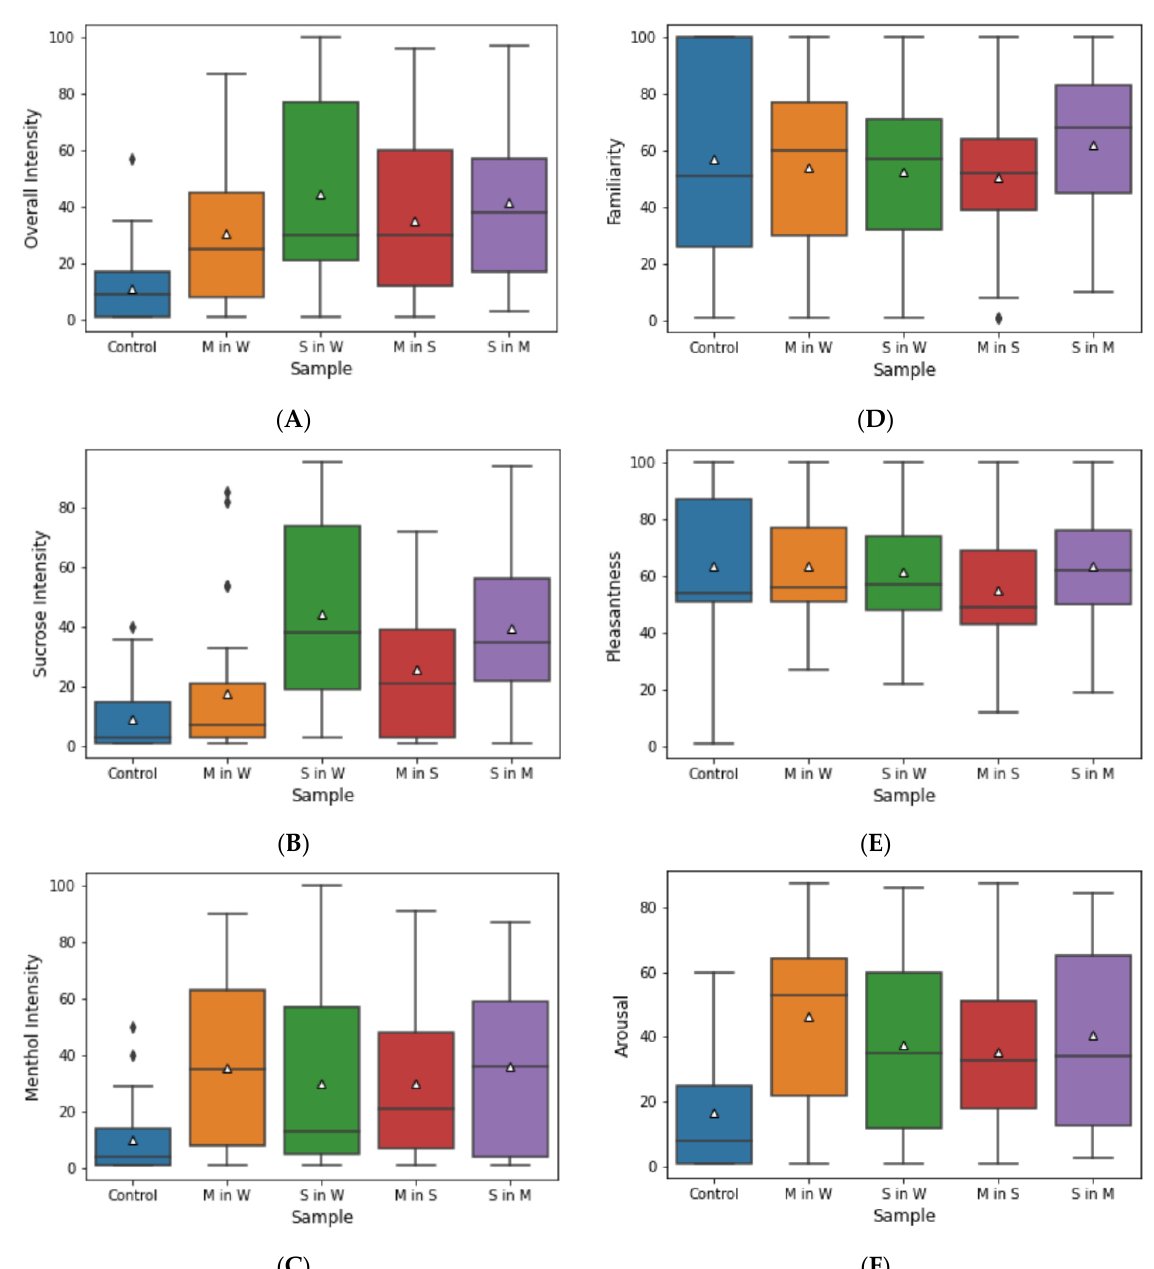
Figure 4. Conscious rating of water (control), menthol in water (M in W), sucrose in water (S in W), menthol in sucrose solution (M in S), and sucrose in menthol solution (S in M). Twenty-nine participants conducted the rating; intensity was rated on a scale from non- to strongly perceptible. All values were consciously rated by the individual tasters. △ symbolize the mean value, ◆ denote outlier values. Overall intensity of all samples ( A ). Intensity of sucrose perception ( B ). Intensity of Menthol perception ( C ). Familiarity of the samples was rated on a scale from not familiar to very familiar ( D ). Pleasantness of the samples, rated from very unpleasant to very pleasant ( E ). Arousal induced by the samples, rated from not arousing to very arousing ( F